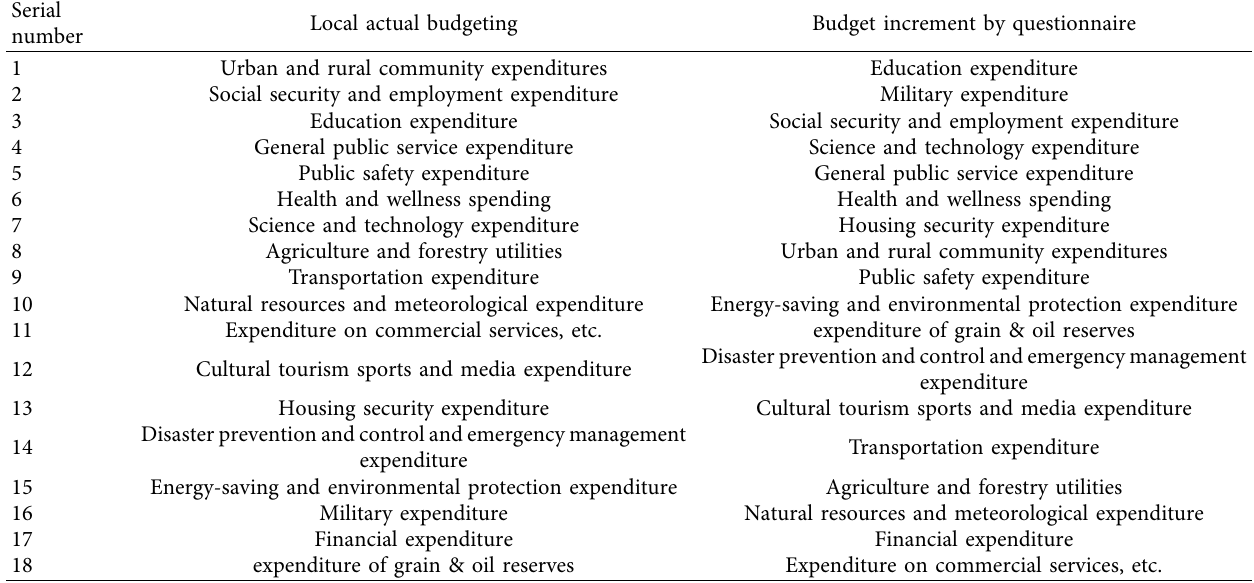
Table 5: Comparison with local actual budgeting